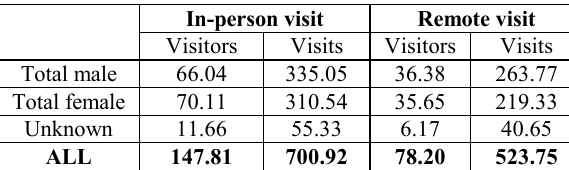
Table 1: Number of visits and visitors to museums by adults, in- person and remotely in 2006.